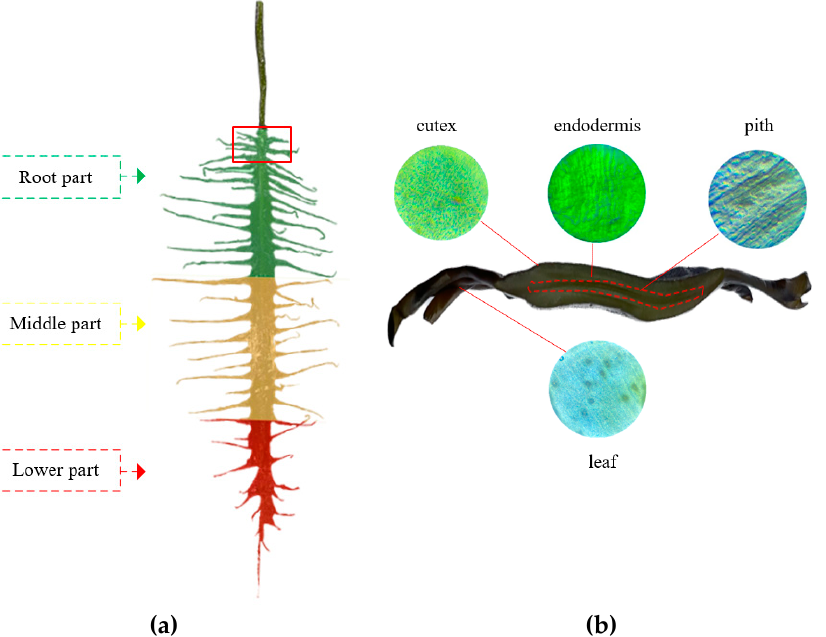
Figure 1. Macromorphology and microstructure of wakame ( a ) Macromorphology of wakame ( b ) microstructure of wakame.